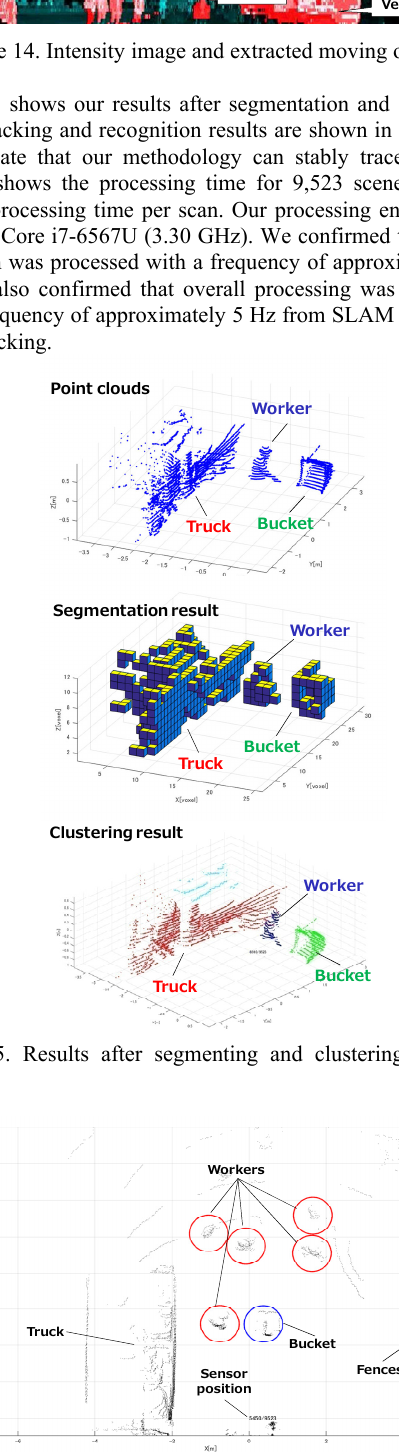
Figure 16. Worker recognition results (plan view)